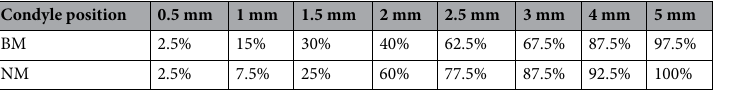
Table 3. Superimposition of CPI and MRI data. Percentage of measuring points within categories of 0.5 to 5 mm of 3D Euclidean distance between corresponding CPI and MRI points, separately for bimanual guidance (BM) and neuromuscular technique (NM), n = 40.